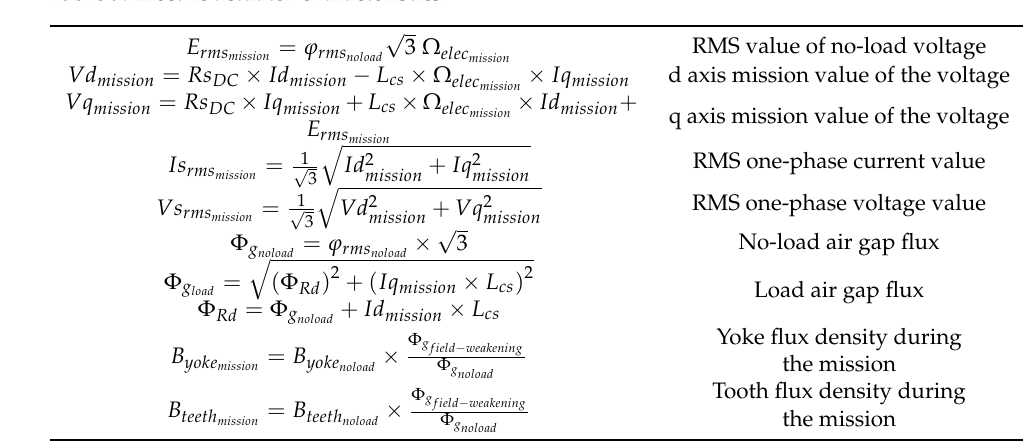
Table 9. Electric actuator characteristics.